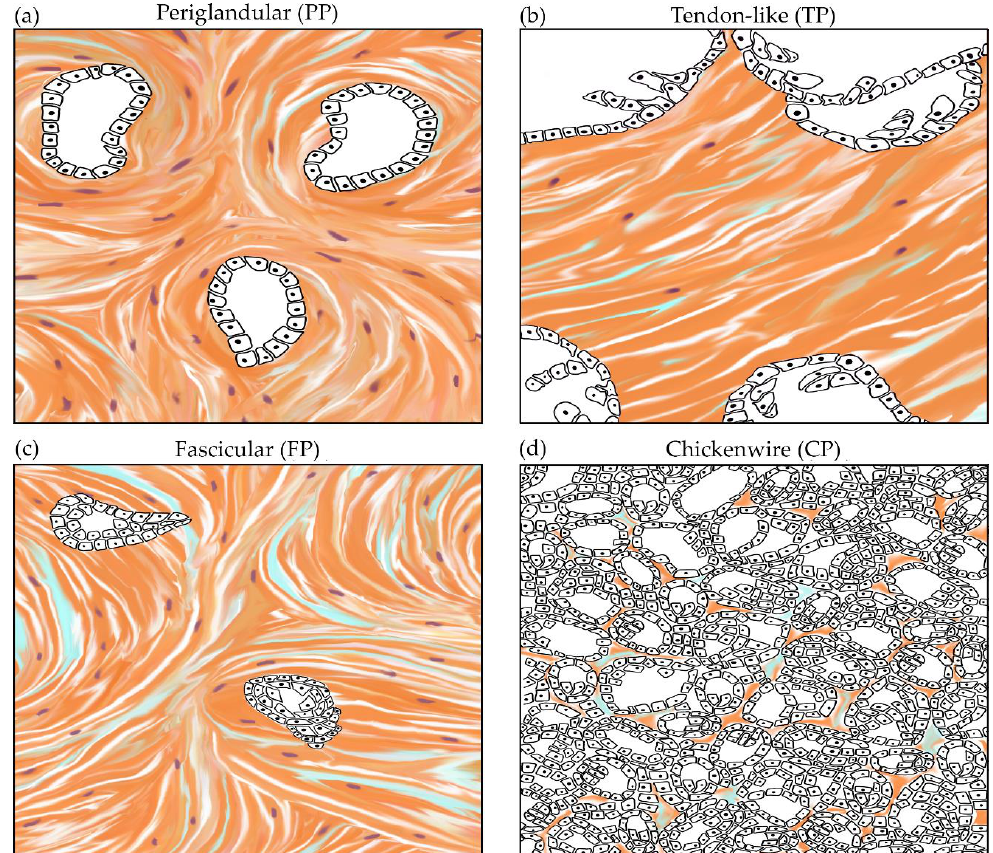
Figure 1. Four patterns of pancreatic cancer with distinctive morphological features of the cancer-cell and stromal com- partments. ( a ) The periglandular pattern (PP) is characterized by medium-sized simple glands surrounded by a moderate amount of stroma that encircles the tumor glands. ( b ) In the tendon-like pattern (TP), the large cystic-papillary tumor glands are embedded in a vast and dense fibrous stroma. ( c ) The fascicular pattern (FP) typically contains medium-sized tumor glands that are often angulated and lie in a highly cellular, whorled stroma. ( d ) In the chickenwire pattern (CP), tumor glands are small and lie densely packed with little intervening stroma.